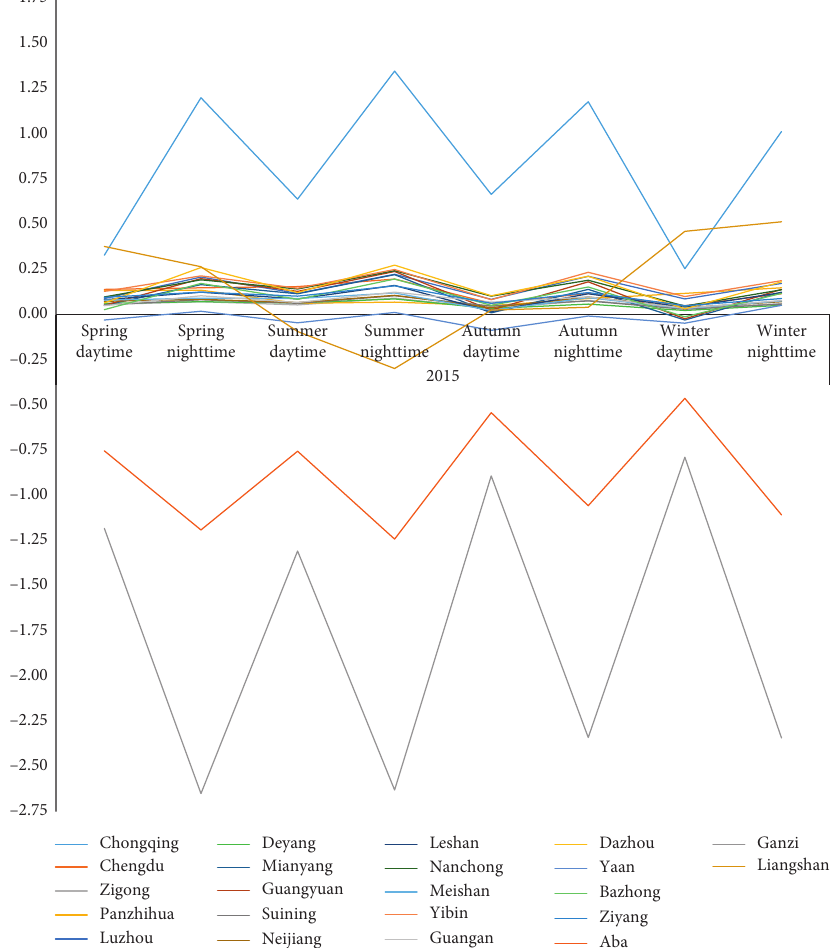
Figure 5: The seasonal CIs of 22 cities in the Sichuan-Chongqing region in 2015. Table 1: The CI of different ecosystem types for Sichuan-Chongqing region between 2005 and 2015.